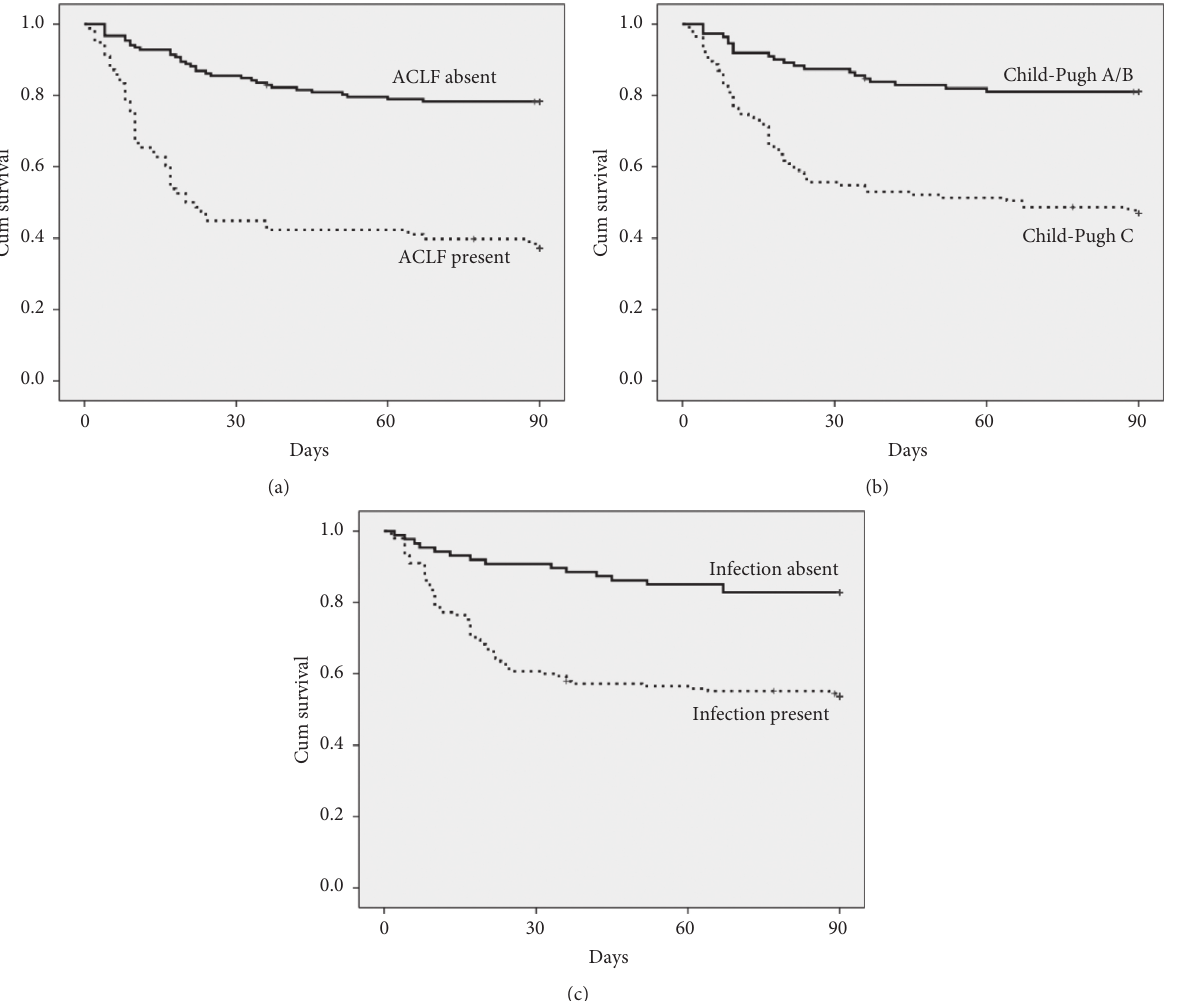
Figure 3: Factors associated with 90-day survival among patients with SIRS. The 90-day survival probability was 78.3% for patients without ACLF and 37.2% for with ACLF (a). Survival was 81.1% among Child-Pugh A/B patients and 47.0% among Child-Pugh C (b). Infection was also strongly related to lower survival among SIRS patients (53.8% vs. 82.8%, P < 0.001)